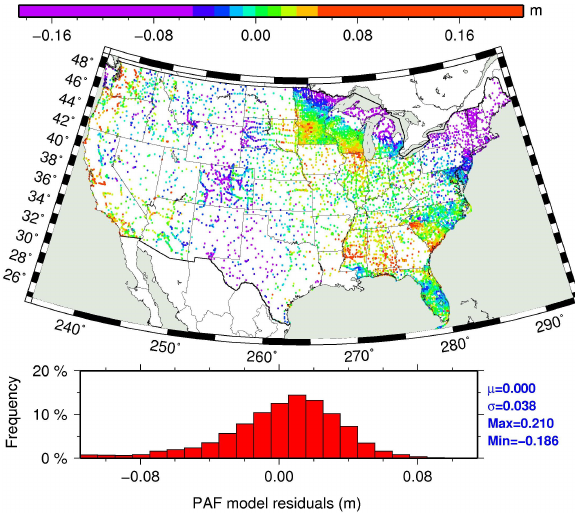
Figure 5: The model residuals of the PAF method (rms = 3.8